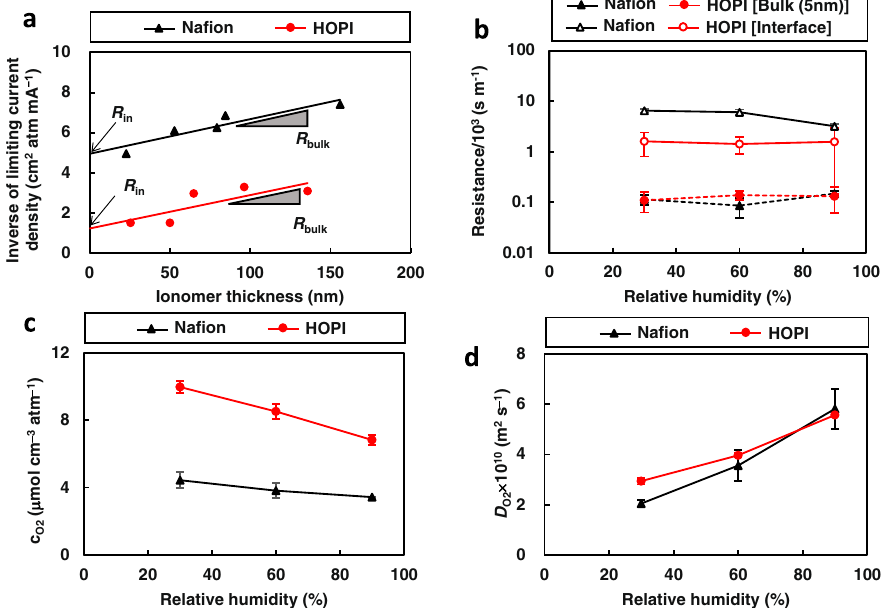
Fig. 4 Electrochemical characterizations of microelectrodes. a Inverse of the limiting current density as a function of the ionomer thickness at 353 K and 30% RH. The bulk ( R bulk ) and interfacial ( R in ) resistances are determined by the slope and intercept of the linear line, respectively. b Interfacial (open symbols with solid lines) and bulk (solid symbols with dashed lines) oxygen permeation resistance of ionomer thin fi lms measured by the microelectrode technique. c , d Oxygen solubility and diffusion coef fi cient of ionomer thick fi lms measured by the microelectrode technique. In b , the bulk resistance was calculated assuming an ionomer thickness of 5 nm. The error bars shown in ( b ) were calculated from fi tting errors assuming the normal error distributions, and the error bars shown in ( c ) and ( d ) show the differences between two